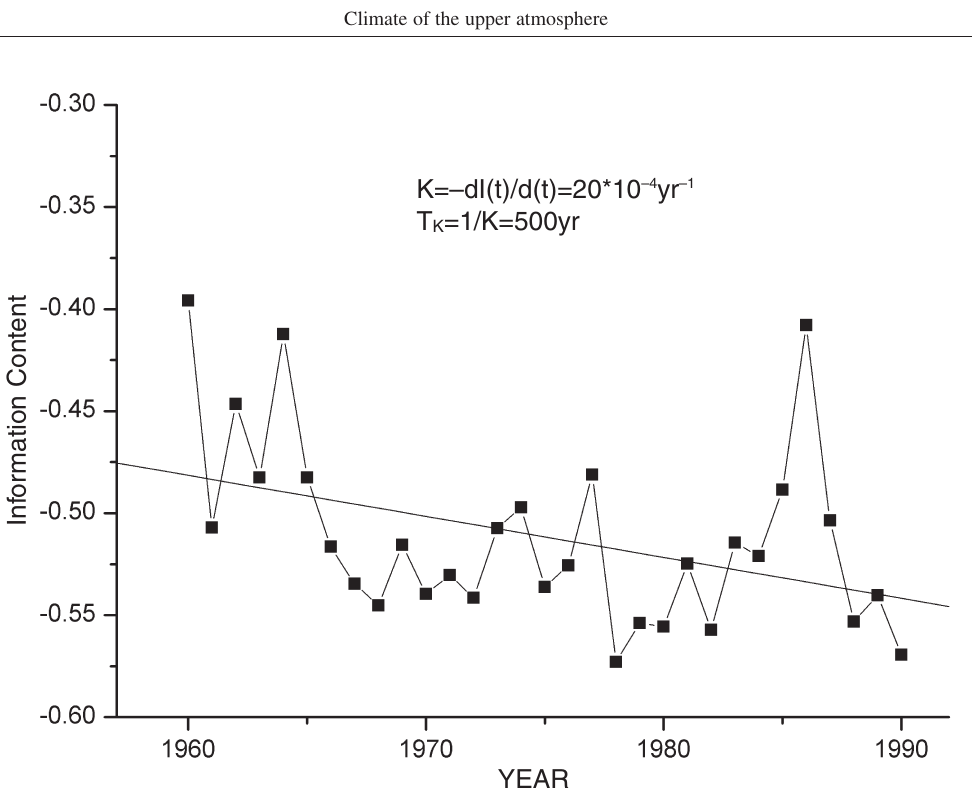
Fig. 2. Information Content applied to foF 2 monthly medians from a set of stations at high southern latitudes in dependence on time. The time scale Τ κ of about 500 years is comparable with that obtained for the geomagnet- ic secular variation over Antarctica (Alfonsi et al .,